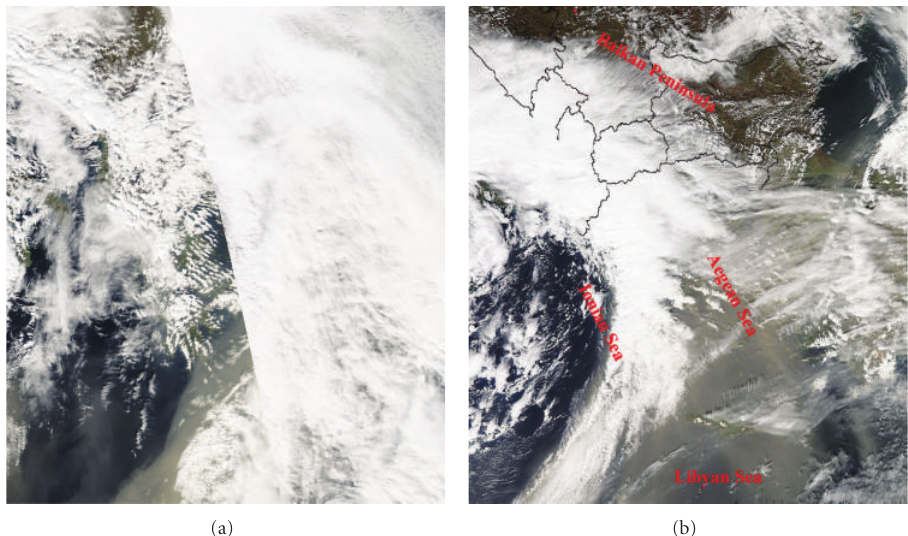
Figure 2: Satellite images from Aqua-MODIS sensor on March 5, 2009 (a) and March 6, 2009 (b).